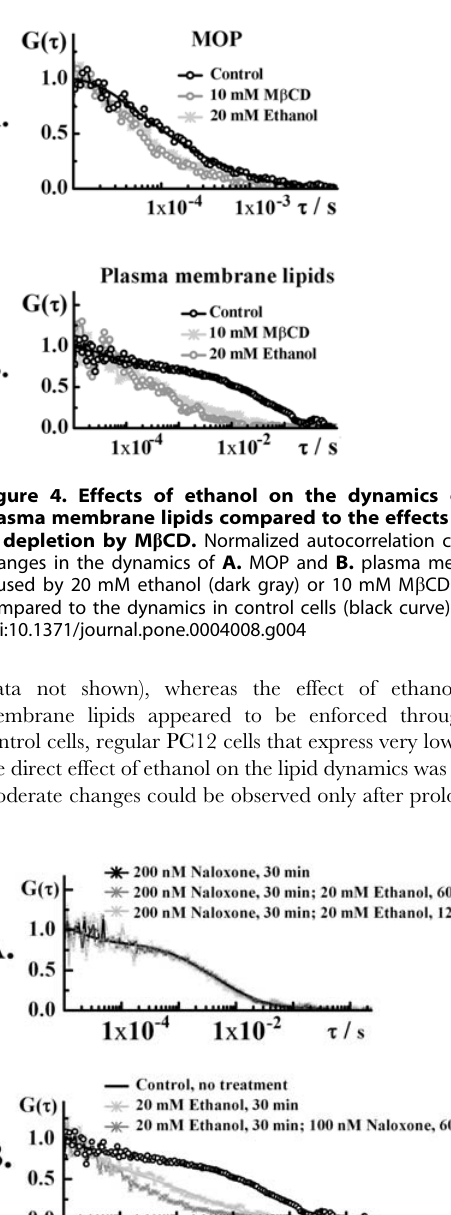
Figure 5. Modulation of ethanol-induced effects by naloxone. A. Normalized autocorrelation curves reflecting the dynamics of plasma membrane lipids in control cells (black curve), cells treated with 20 mM ethanol for 30 min (dark gray) and cells treated with 20 mM ethanol for 30 min, followed by treatment with 200 nM naloxone for 60 min (light gray). The characteristic decay time of the autocorrelation curves is decreased even after addition of naloxone. B. Normalized autocorre- lation curves reflecting the dynamics of plasma membrane lipids in cells exposed to 200 nM naloxone for 30 min (black curve), cells treated with 200 nM naloxone for 30 min, followed by a 60 min exposure to 20 mM ethanol (dark gray) and cells treated with 200 nM naloxone for 30 min, followed by a 120 min exposure to 20 mM ethanol. The characteristic decay time of the autocorrelation curves remained unchanged, suggesting that the dynamics of MOP and plasma membrane lipids is largely unaffected. These findings suggest that effects of ethanol on the dynamics of MOP and the plasma membrane lipids are not easily reversed by naloxone or naltrexone. However, pre-treatment with these substances slows down the effects of